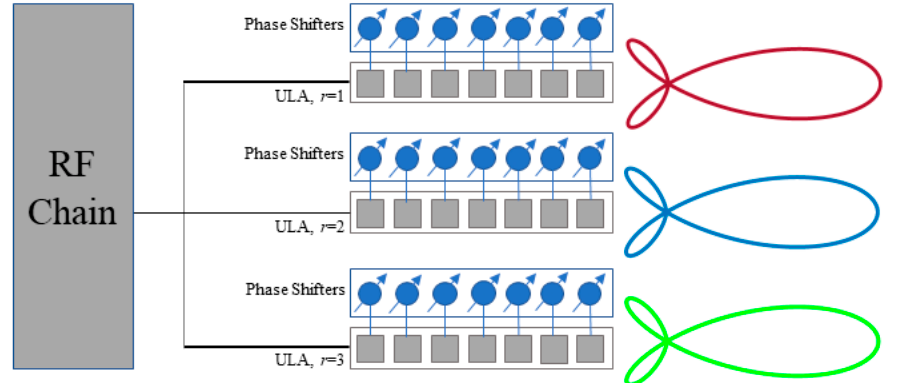
Figure 1. Proposed parallel analog beamformer.